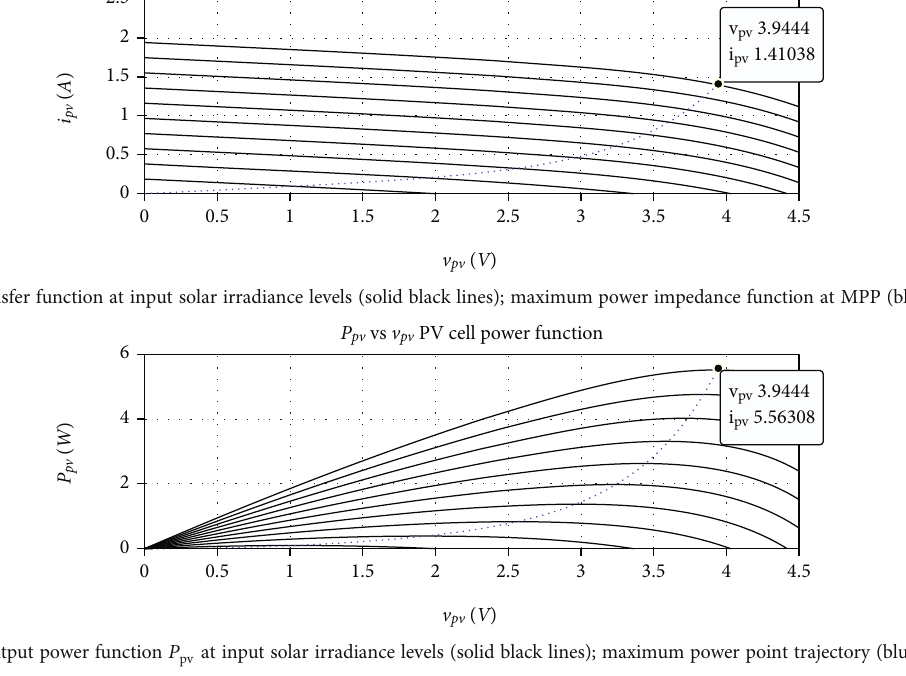
Figure 5: The PV cell ’ s transfer and output power functions at several input solar irradiance